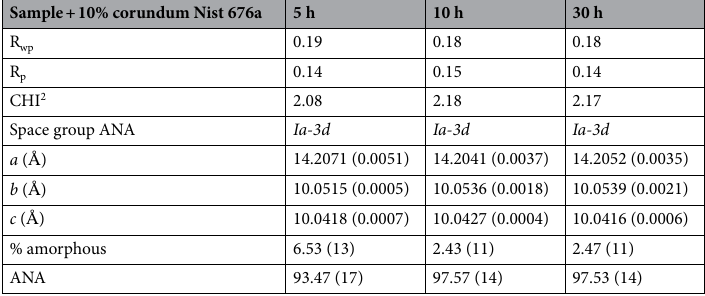
Table 1. Results of the QPA analyses conducted on samples synthesized at 170 °C.